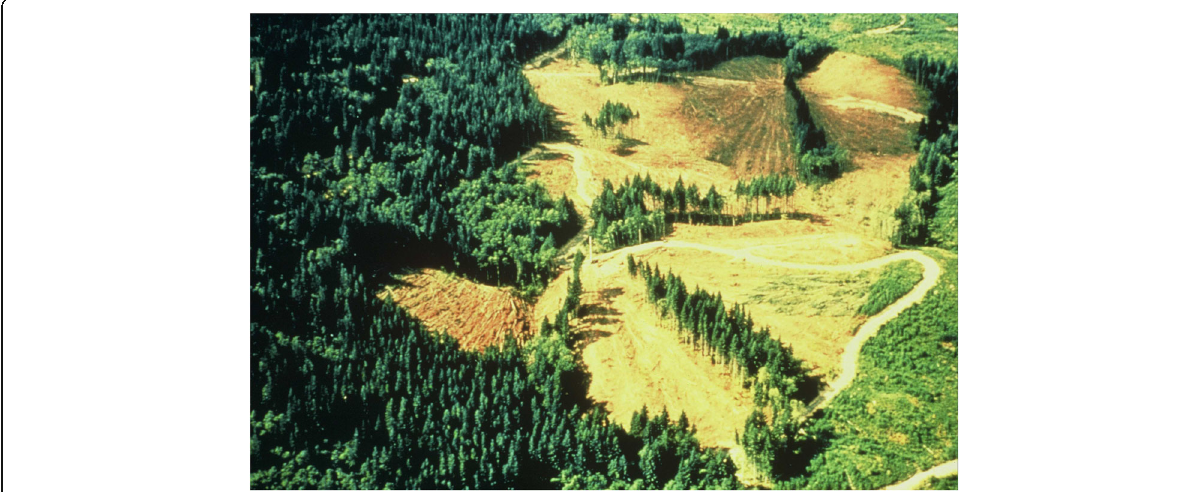
Fig. 4 After experimenting with different approaches to retention, the Plum Creek Timber Company found aggregated retention, as seen here on the Cougar Ramp Unit, was an effective approach to integrating environmental and timber management objectives. This cutting opened the senior author ’ s mind to the potential of aggregated retention, which today is generally viewed as the most important approach for conserving a broad array of